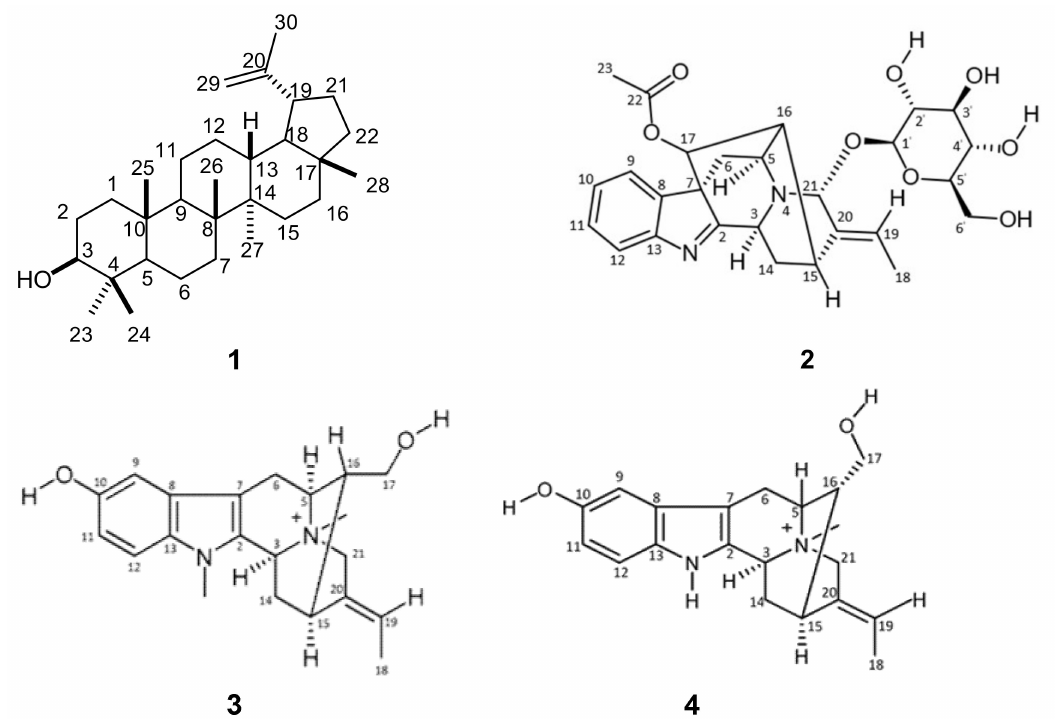
Figure 1. Isolated triterpenoid 1 and indole alkaloids 2 – 4